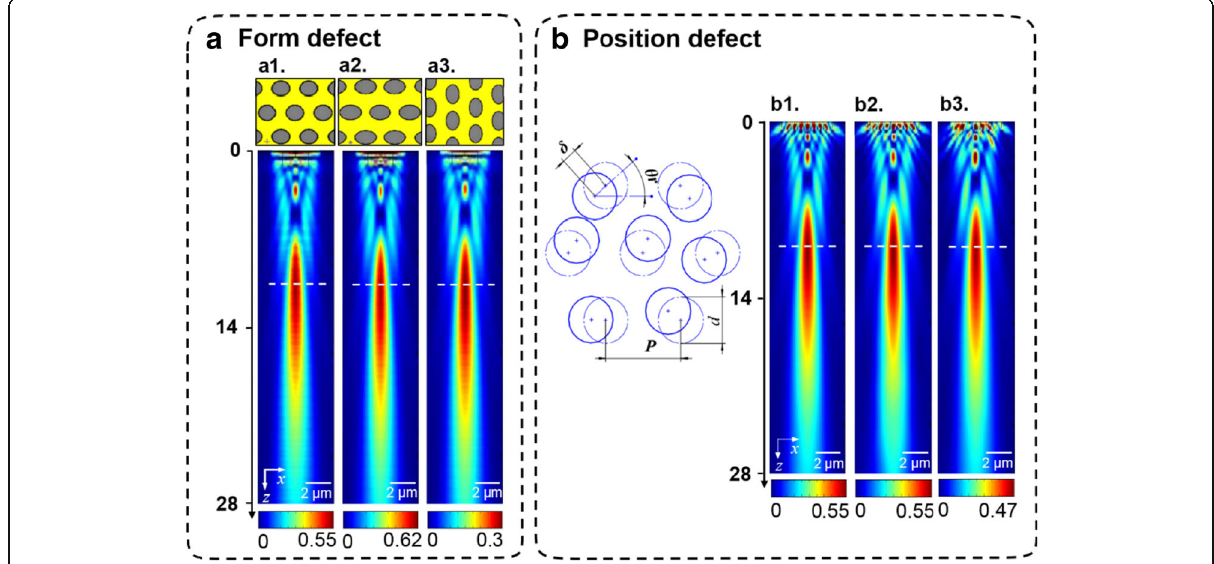
Fig. 7 a Focal spots from microlenses are independent of the out-of-roundness error σ of nanoholes. The focusing properties do not show a clear change when σ = 0 (rounded nanoholes) in Fig. 5 is increased to a1 σ = 0.4, a2 σ = 0.7 with a horizontal distorted direction, and a3 σ = 0.7 with a perpendicular distorted direction. b Introduction of spatial randomness into the positions of nanoholes. Deviation directions are randomly different from hole to hole, but the deviation length δ is kept constant for each hole. The same focusing patterns are obtained when the deviation length b1 δ = 0, b2 δ = 50 nm, and b3 δ = 100